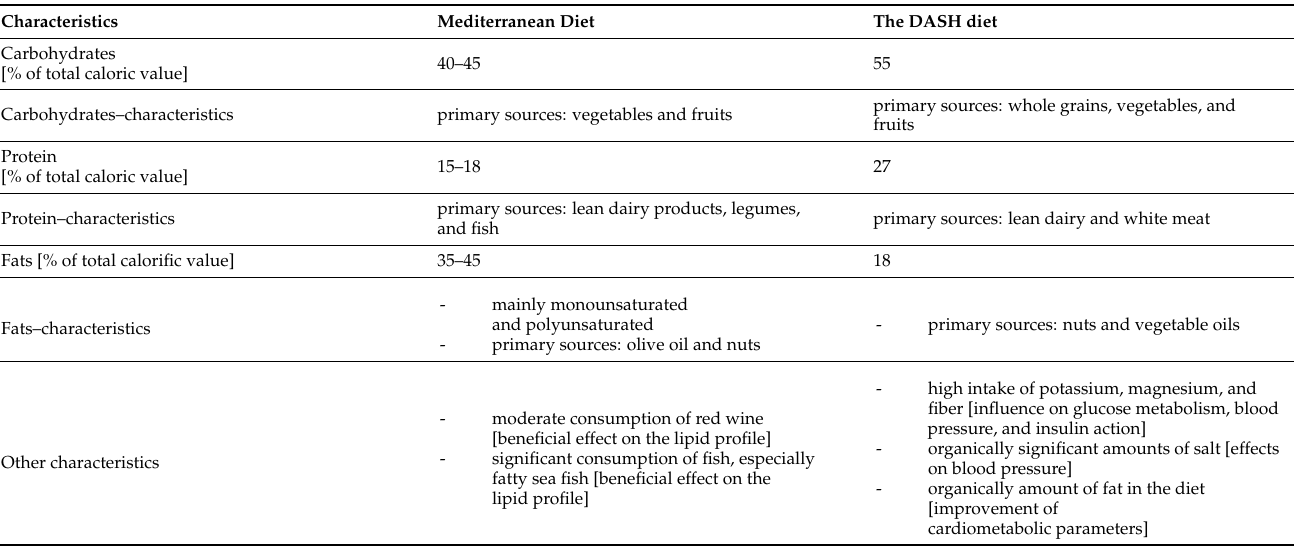
Table 3. Assumptions of the Mediterranean diet and the DASH diet, based on